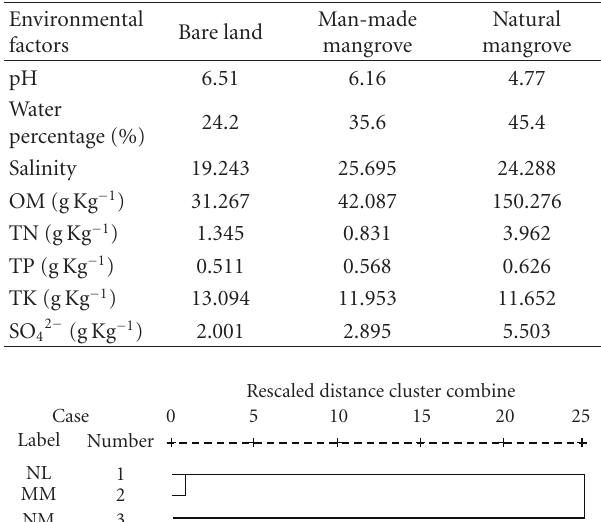
Table 2: Ciliate species found in all soil samples from the mangrove forest of Dongzhaigang, Hainan,